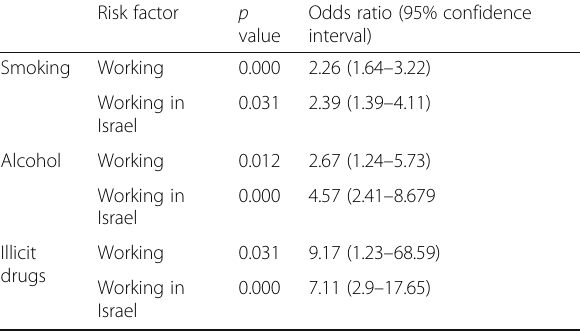
Table 6 Odd ratios for the most associated risk factors with substance use Risk